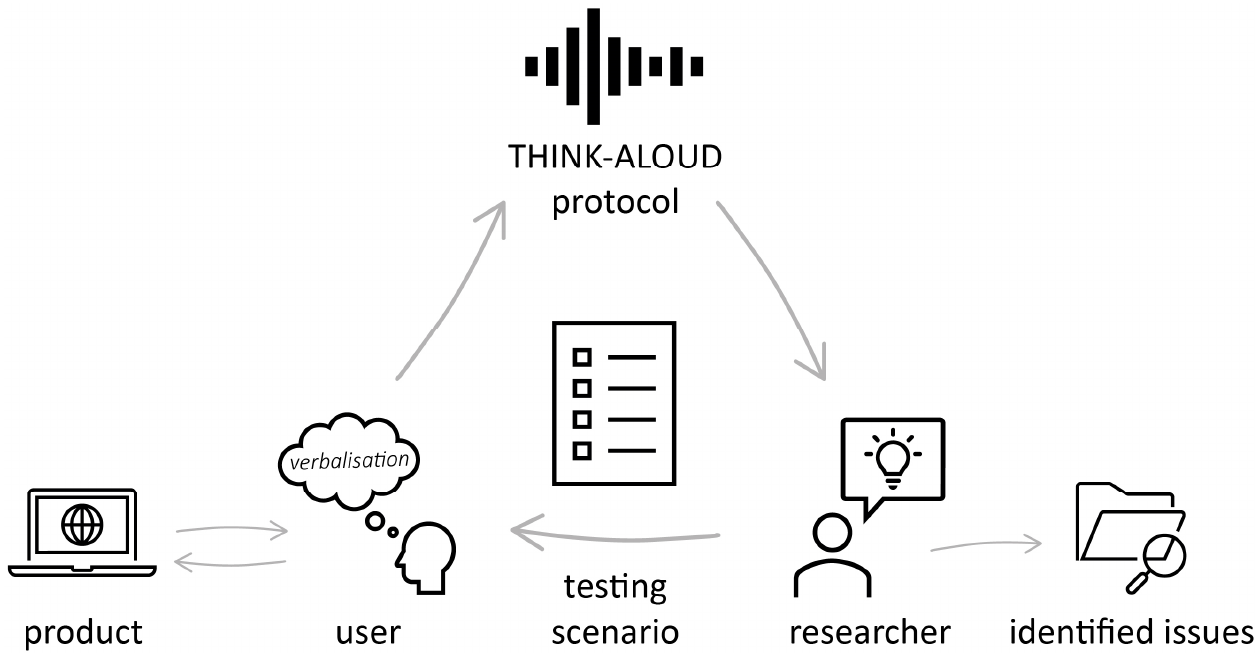
Figure 2. The principle of the think-aloud method.